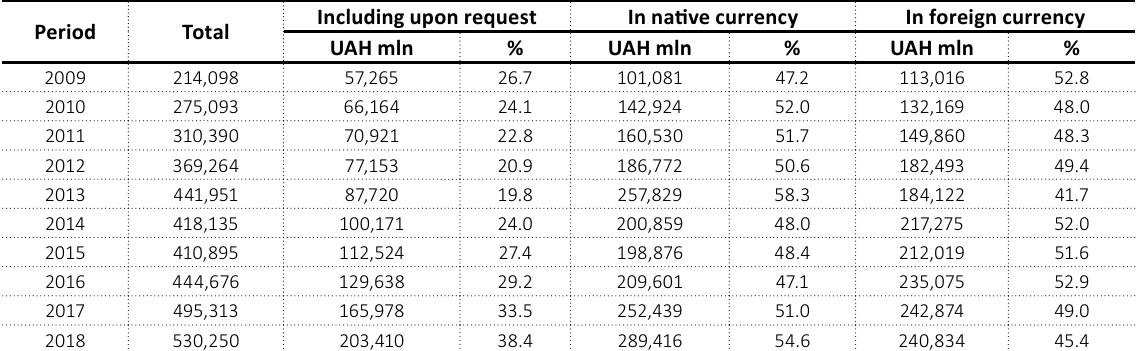
Source: Compiled based on the National Bank of Ukraine (2019c) data.